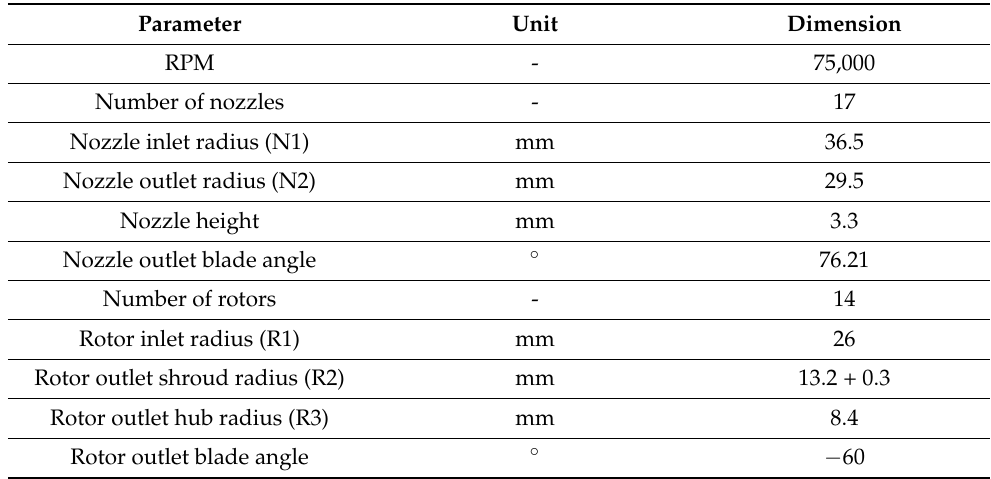
Figure 2. Meridional view of expander. Table 4. Meanline design results.